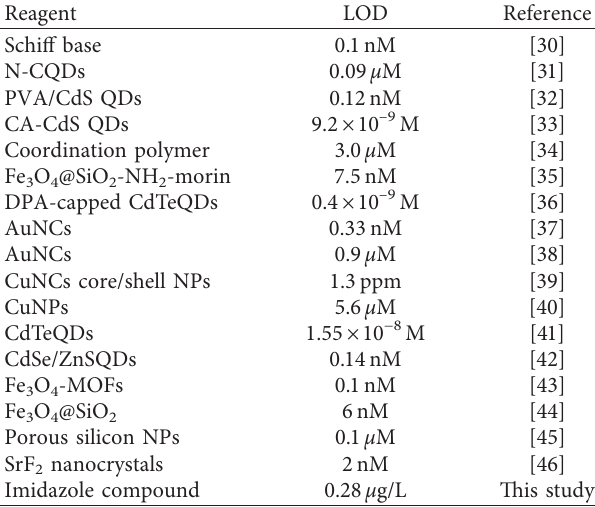
Table 3: Detection limits of fluorimetric Cu 2+ determination methods in tap